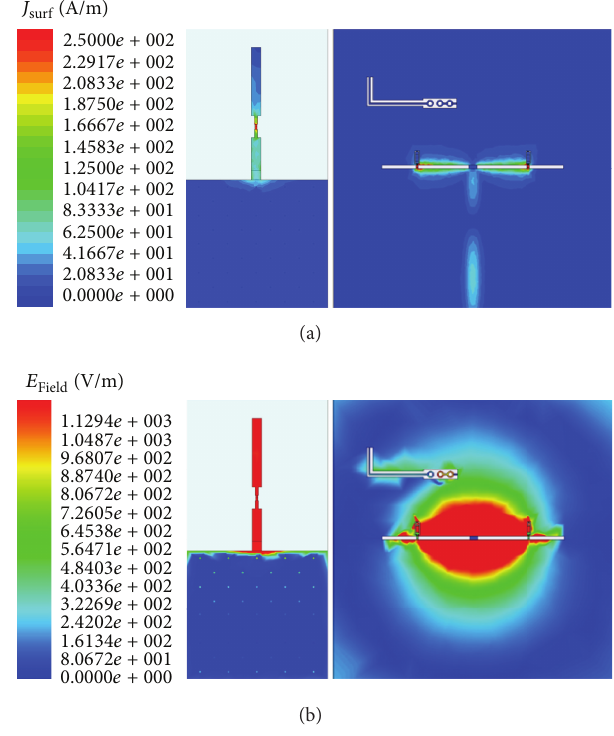
Figure 21: Field distribution on the reconfigurable antennas with Diode I; (a) the surface current density ( J [A/m]) and (b) the surface electric field intensity ( E